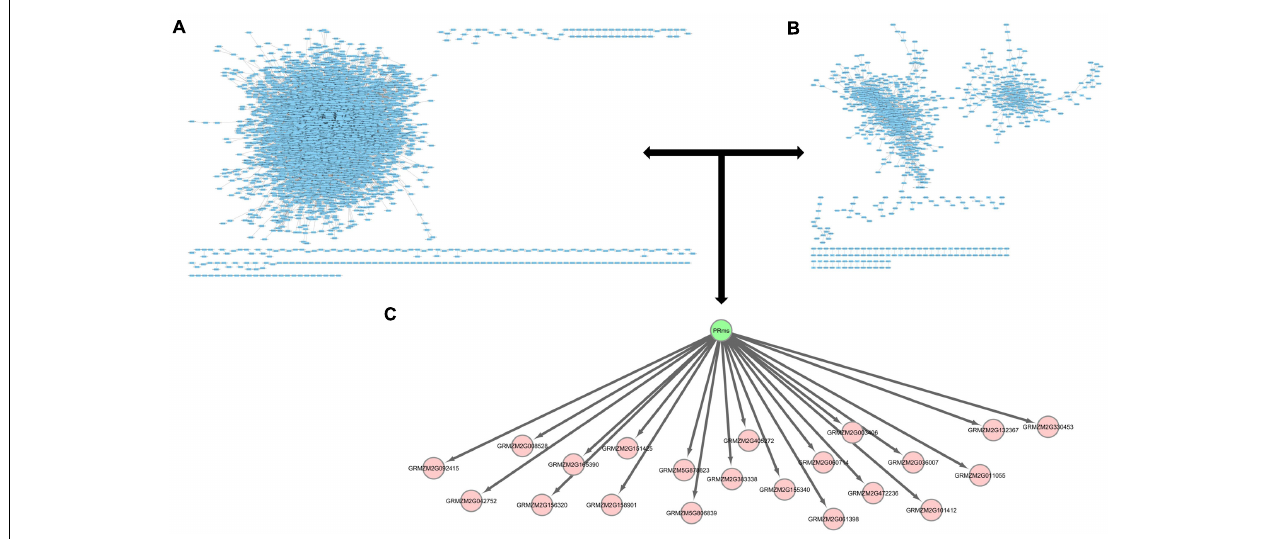
FIGURE 5 | Potential downstream targets of ZmPRms . (A) The predicted maize interactome (Musungu et al., 2016); (B) a maize co-expression network (Musungu et al., 2016); (C) potential ZmPRms transcriptional targets.